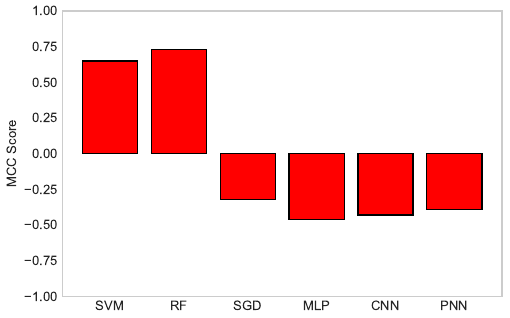
Figure 10. MCC score comparison of SVM, RF, SGD, MLP, CNN, and PNN classifiers.